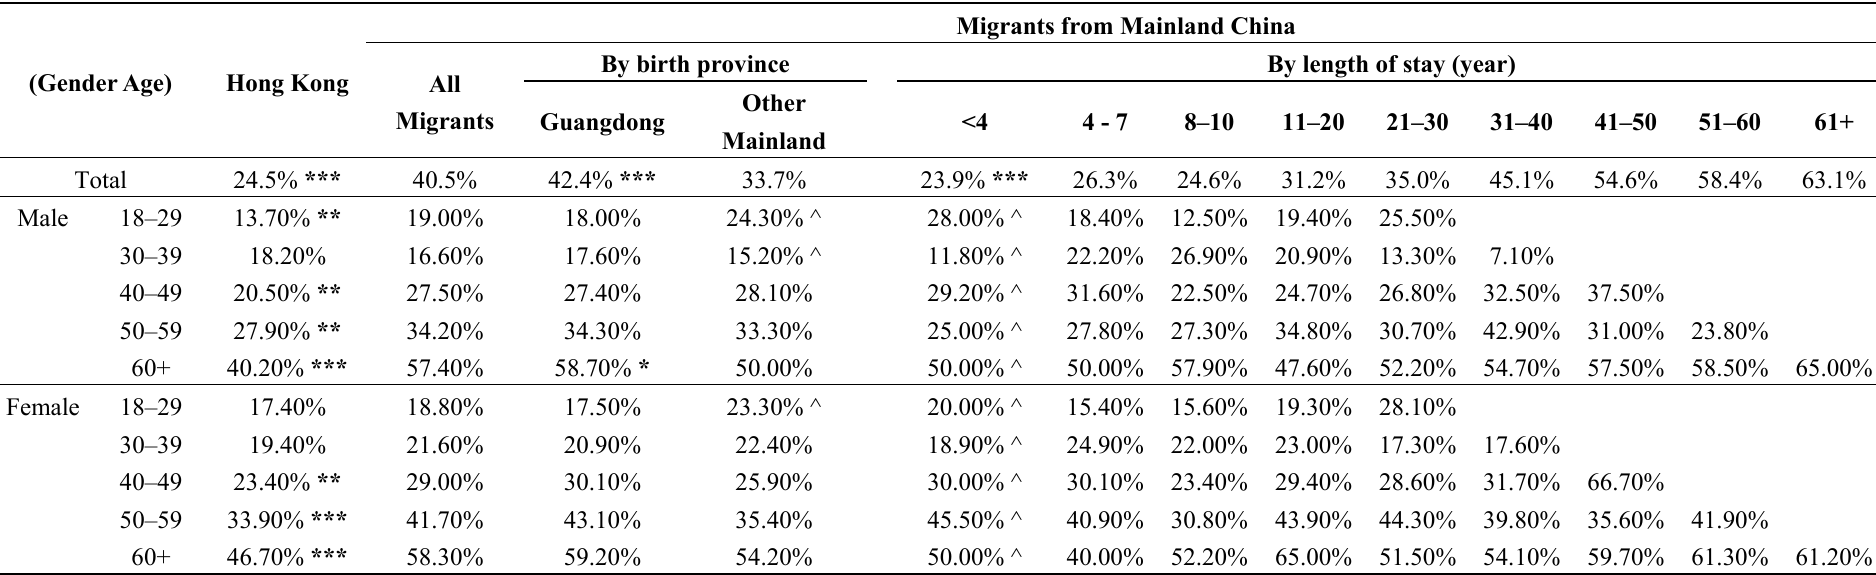
Table 2. Overall health status (% fair/poor) among Hong Kong residents and mainland migrants, by age and